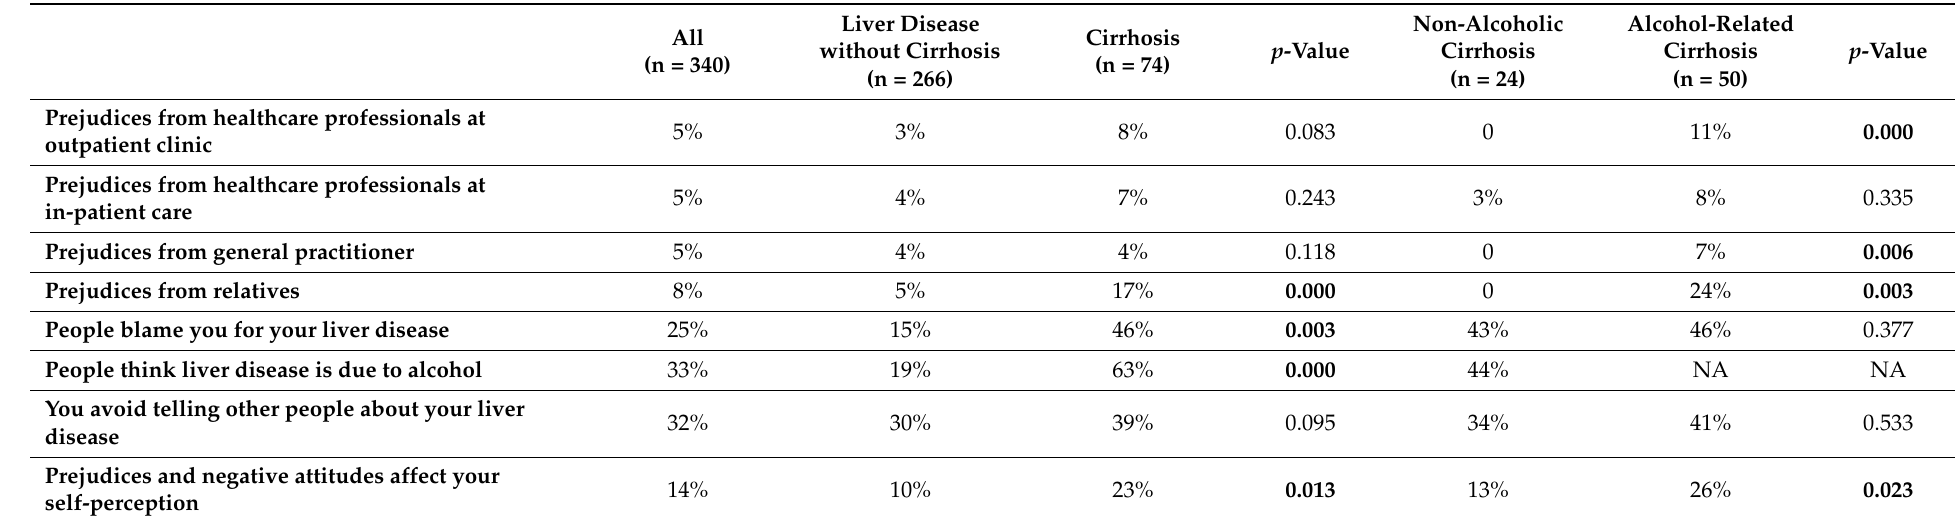
Table 4. Assessment of